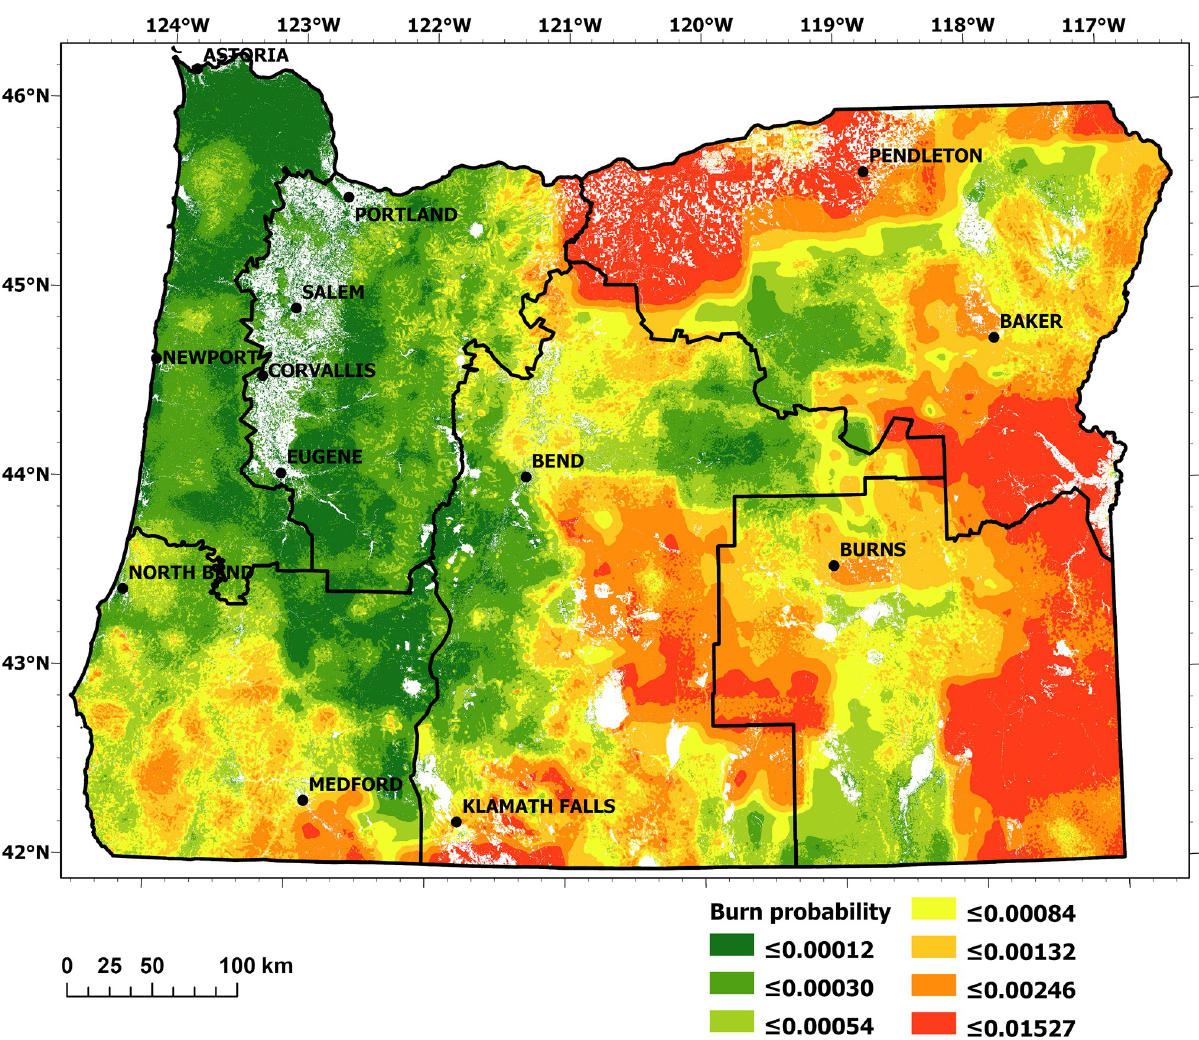
Fig 3. Burn probability for all FSAs using worst-case meteorological data on record during peak fire season from the 50 selected weather